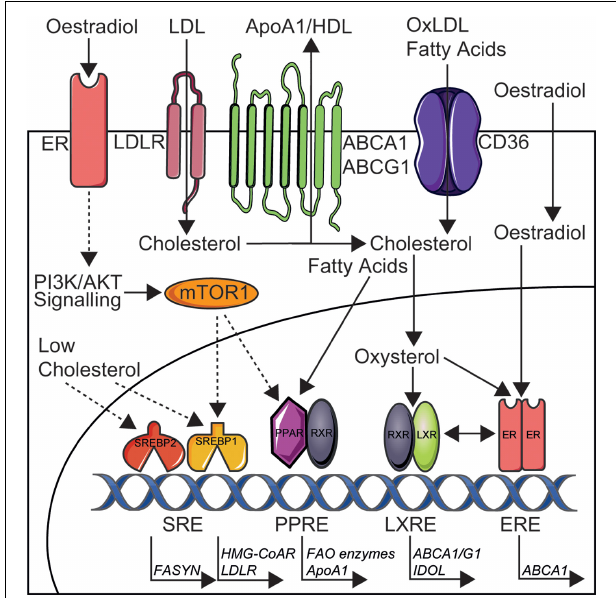
FIGURE 3 | Simplified depiction of oestradiol induced signalling pathways that may increase cardioprotection in women through altered lipid metabolism and could be targeted in SLE. Cholesterol is taken up by cells in low density lipoproteins (LDL) via LDL receptors (LDLR) and CD36 [oxidised (ox)LDL] or is synthesised by HMG-CoA reductase (HMG-CoAR). Cholesterol is removed from cells to ApoA1/high density lipoproteins (HDL) via ATP-binding cassette transporter A1 or G1 (ABCA1/G1) or converted to oxysterols intracellularly. Low intracellular cholesterol levels can induce the transcriptional activity of sterol regulatory element-binding proteins 1/2 (SREBP1/2). Fatty acids are taken up by CD36, synthesised by fatty acid synthase (FASYN), or metabolised by fatty acid oxidation (FAO). Oestradiol acts via membrane bound oestrogen receptors (ERs) to induce phosphoinositide 3-kinase/protein kinase B (PI3K/AKT) signalling and downstream mTOR1 activation. Activated mTOR1 increases lipogenesis via increased nuclear activity of SREBP1 and peroxisome proliferator-activated receptor (PPAR) transcription factors. Oestradiol can also activate transcription factor ERs in the nucleus and this increased ER nuclear activity can elevate the binding and transcriptional efficiency of liver-x-receptors (LXRs), inducing cardioprotective cholesterol metabolism through upregulated ABCA1/G1 and inducible degrader of the LDLR (IDOL). It is through these metabolic pathways that oestradiol could exert it’s cardioprotective effects in healthy women and therefore could be disrupted and targetted in SLE to reduce CVD risk for patients. This figure was produced using resources from Servier Medical Art, licenced under a Creative Common Attribution 3.0 Generic License.